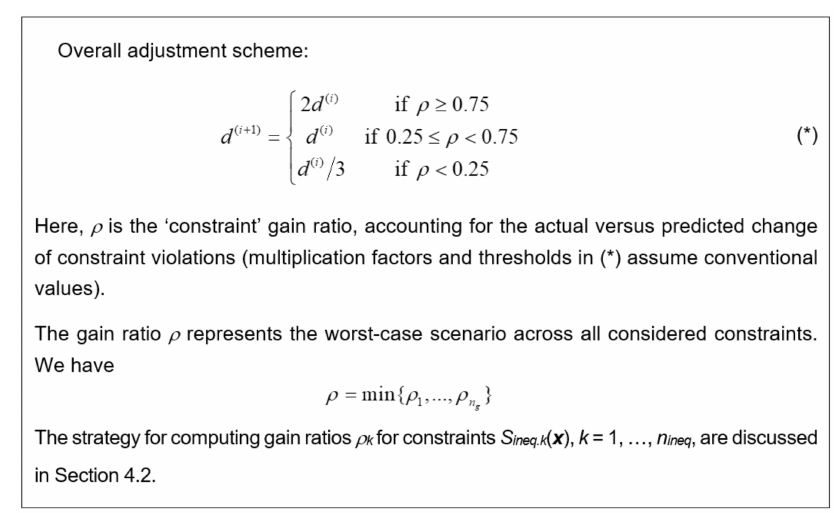
Figure 8. Updating the trust-region size according to the methodology of [44].